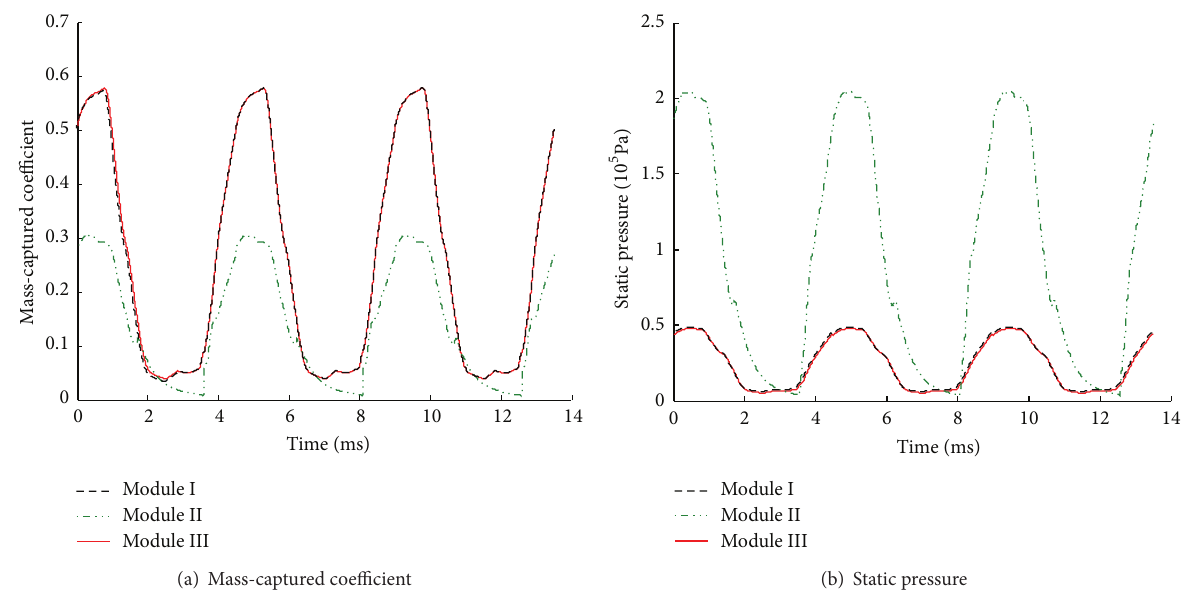
Figure 5: The histories of mass-captured coefficient and static pressure at the exit of